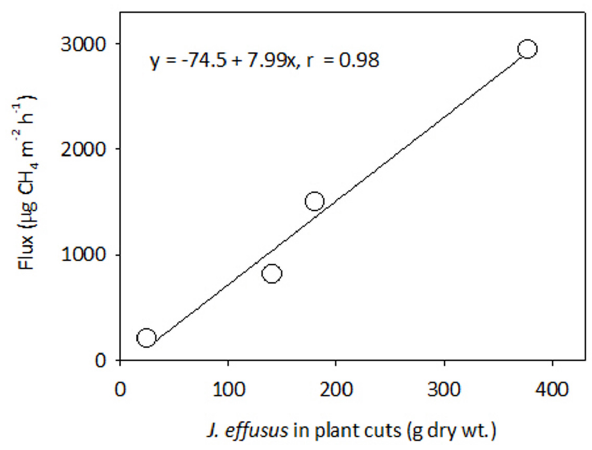
Fig. 10. Relationship between dry wt. of J. effusus stems in the biomass of plant cuts and the mean flux of CH 4 . J. effusus occurred in four individual sampling points, although in one of them only with a few scattered